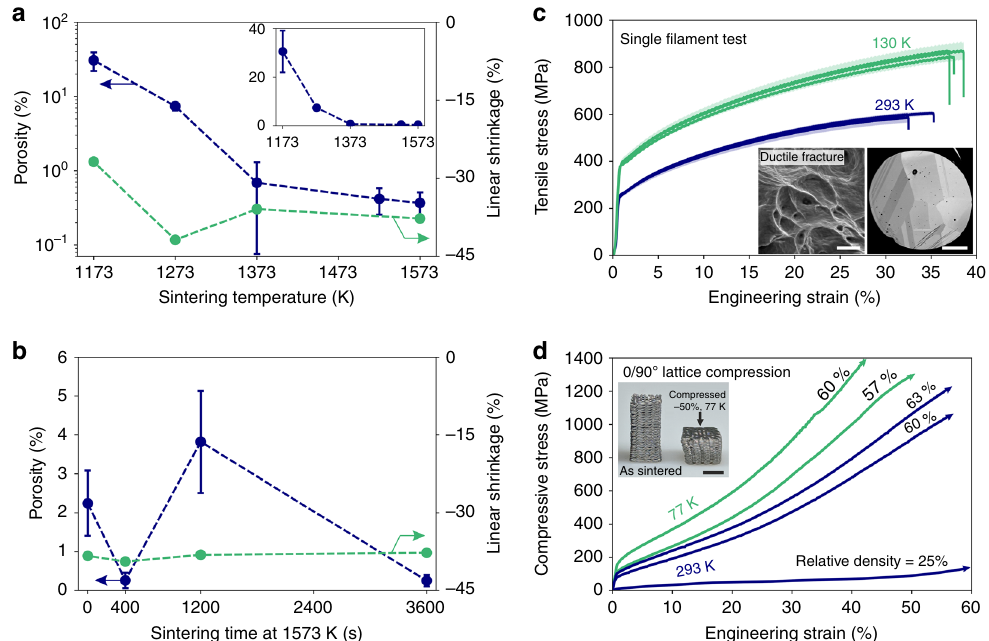
Fig. 4 Porosity evolution and mechanical performance of extrusion-printed 250 µ m CoCrFeNi HEA fi laments. a Evolution of porosity (logarithmic scale, blue) and shrinkage (linear scale, green) with increasing sintering temperature in H 2 for 1 h dwell time. Extensive, reproducible linear shrinkage is observed, with a maximum at 1273 K. Averaged data over all nozzle diameters. Inset: Porosity on a linear scale for comparison. Error bars correspond to ± σ . b Evolution of porosity and shrinkage (both linear scale) with sintering time at 1573 K in H 2 . Error bars correspond to ± σ . c Engineering stress-strain curves of single fi laments (125 µ m average diameter, 10 mm gauge length, from 250 µ m nozzle, sintered at 1573 K/1 h) tested in tension at 130 K (green line) and 293 K (blue line) until fracture. Shading corresponds to the 1 σ error in calculated stress based on the measured cross-sectional area variation of fi laments. Inset: fracture surface showing dimples typical of ductile fracture mode at 293 K (scale bar 1 µ m) and cross-section of a fi lament showing its oligocrystalline structure (grain size: 35 – 80 µ m). Scale bar is 25 µ m. d Compressive stress-strain curve of 0/90° cross-ply CoCrFeNi HEA micro-lattices with 25% (when extruded with a 200 µ m nozzle) to 63% (250 µ m nozzle) relative density, sintered at 1573 K for 1 h, and tested at 77 K (green) and 293 K (blue), showing extensive plastic deformation at all temperatures. All tests were interrupted prior to fracture. Inset: Sintered lattice before (left) and after (right) compression to − 50% at 77 K, showing homogeneous deformation. Scale bar is 2